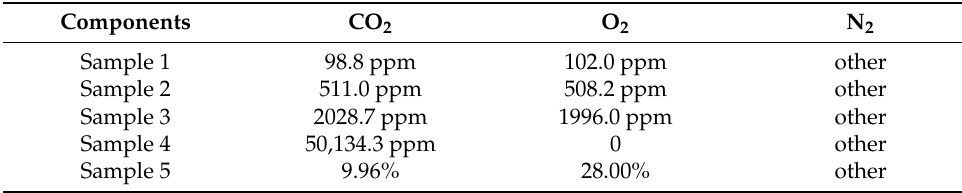
Table 1. The components of samples.